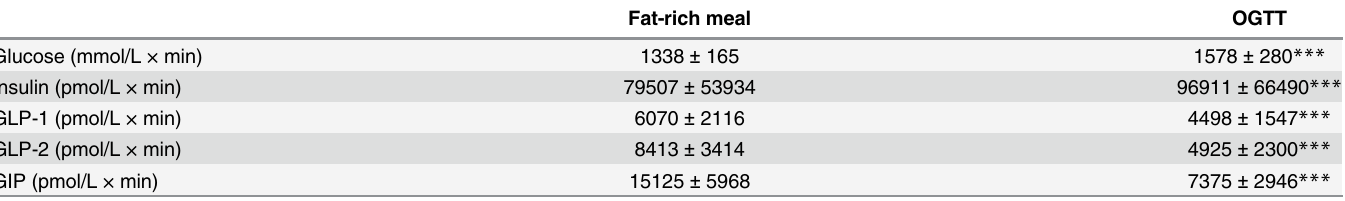
Table 2. Incretin responses after fat-rich meal and OGTT. Areas under curve (AUC) for glucose, insulin, GLP-1, GLP-2 and GIP after the fat-rich meal and after the OGTT calculated between 0 – 240 minutes. Data are mean ± standard deviation. The given p -value shows differences between fat-rich meal and